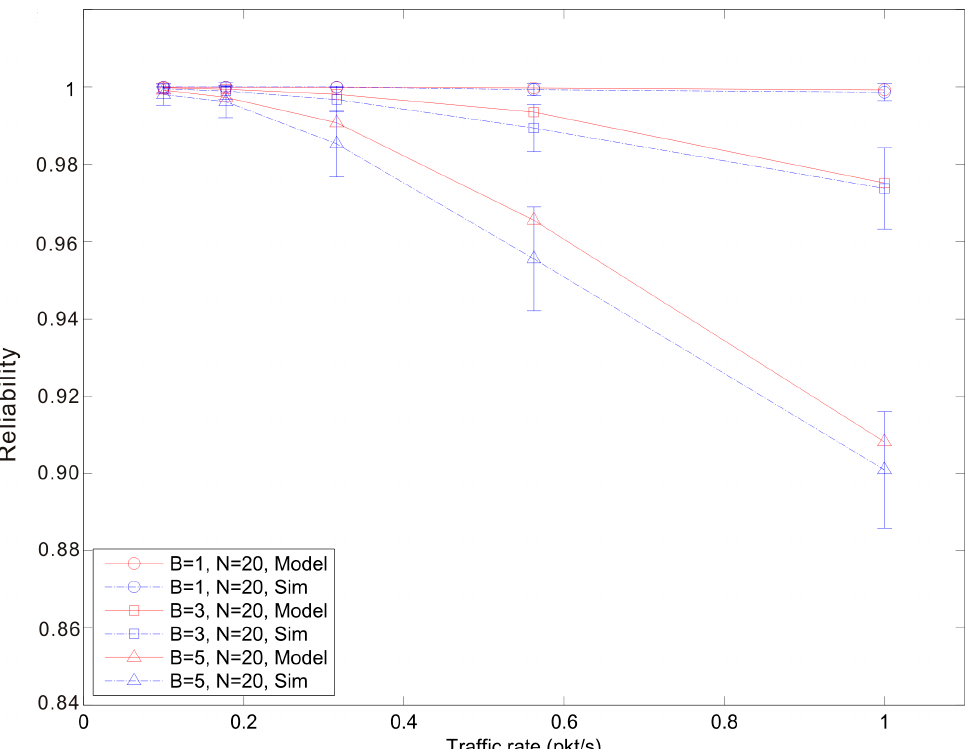
Figure 9. Blockwise reliability versus traffic rate for a star topology network composed by 20